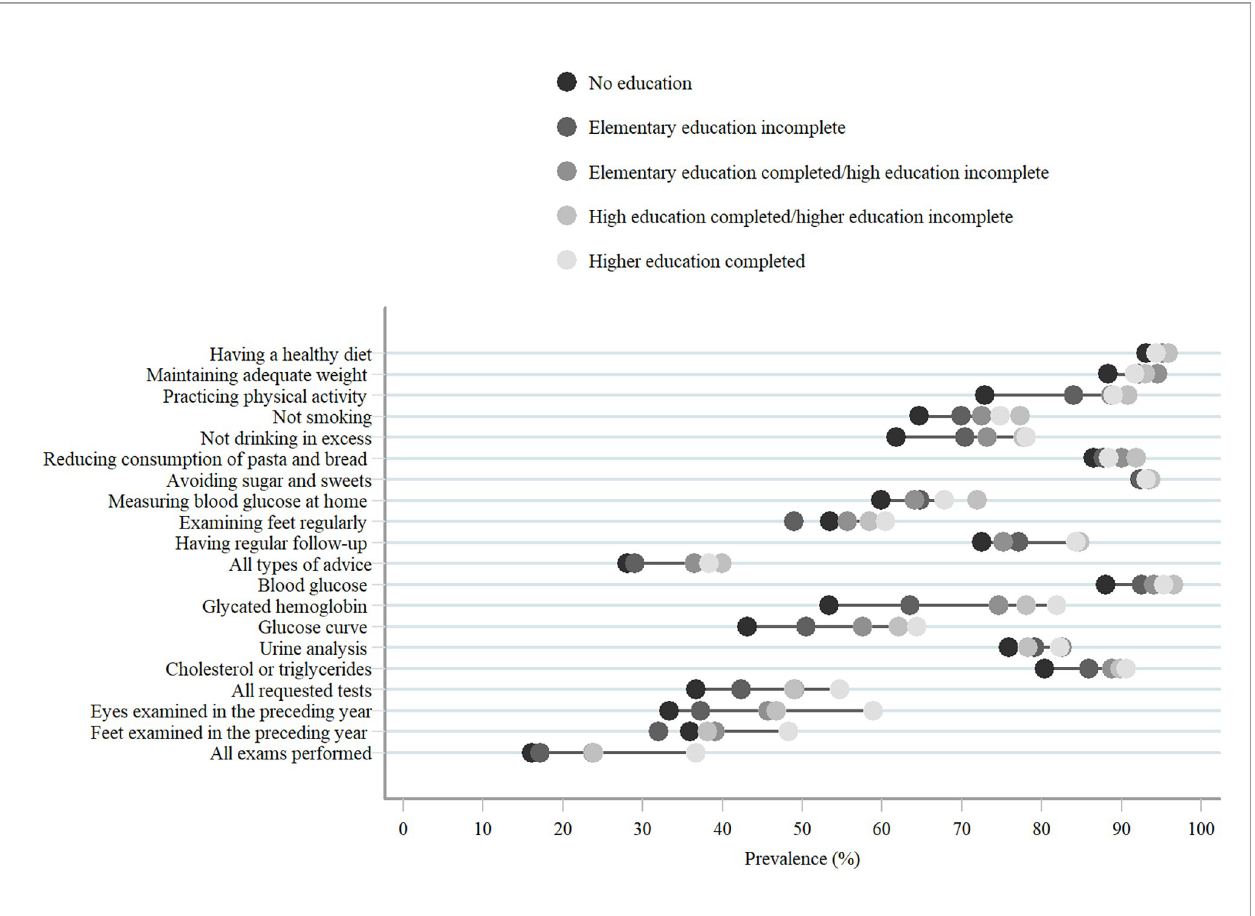
Fig 2. Prevalence (%) of the care services offered to the people with diabetes mellitus, according to educational level, Brazil, 2019, (N = 6317).